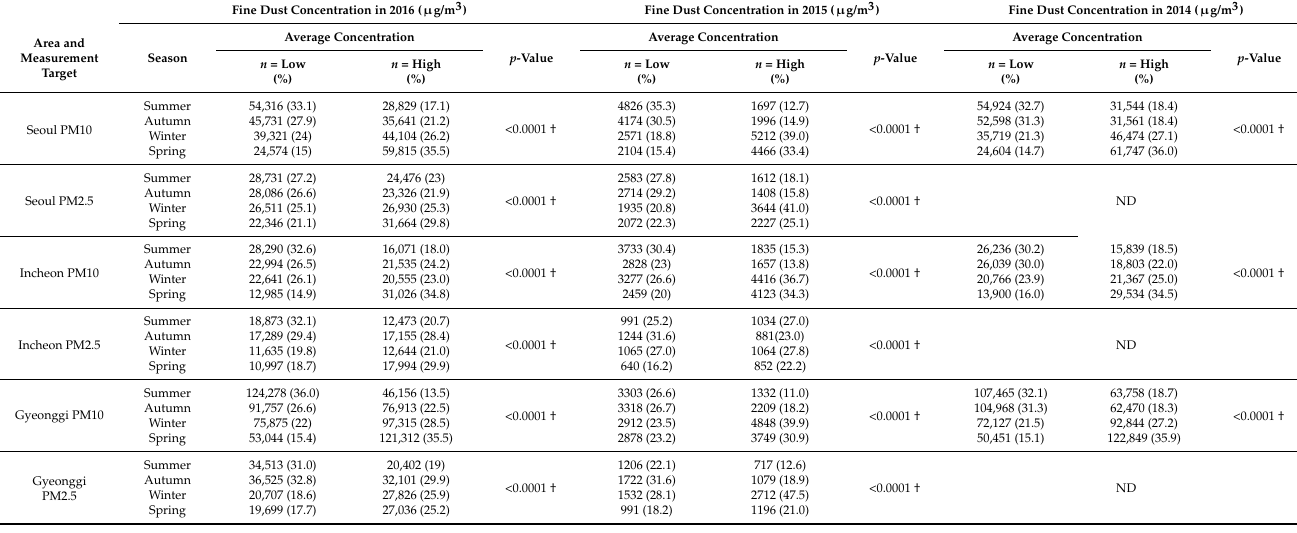
Table 4. Seasonal and average fine dust (PM10 and PM2.5) concentrations (log-linear). FineDustConcentrationin2016( µ g/m3)